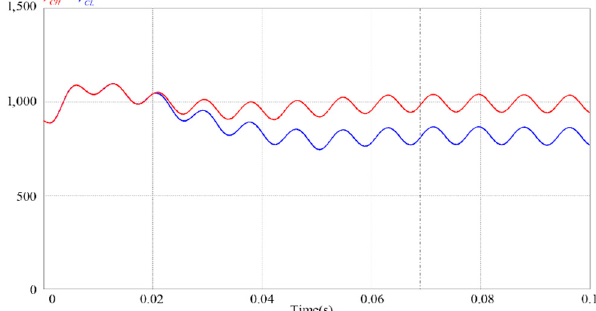
Figure 8. Unbalanced voltage waveforms of upper capacitor V CH and V CL .